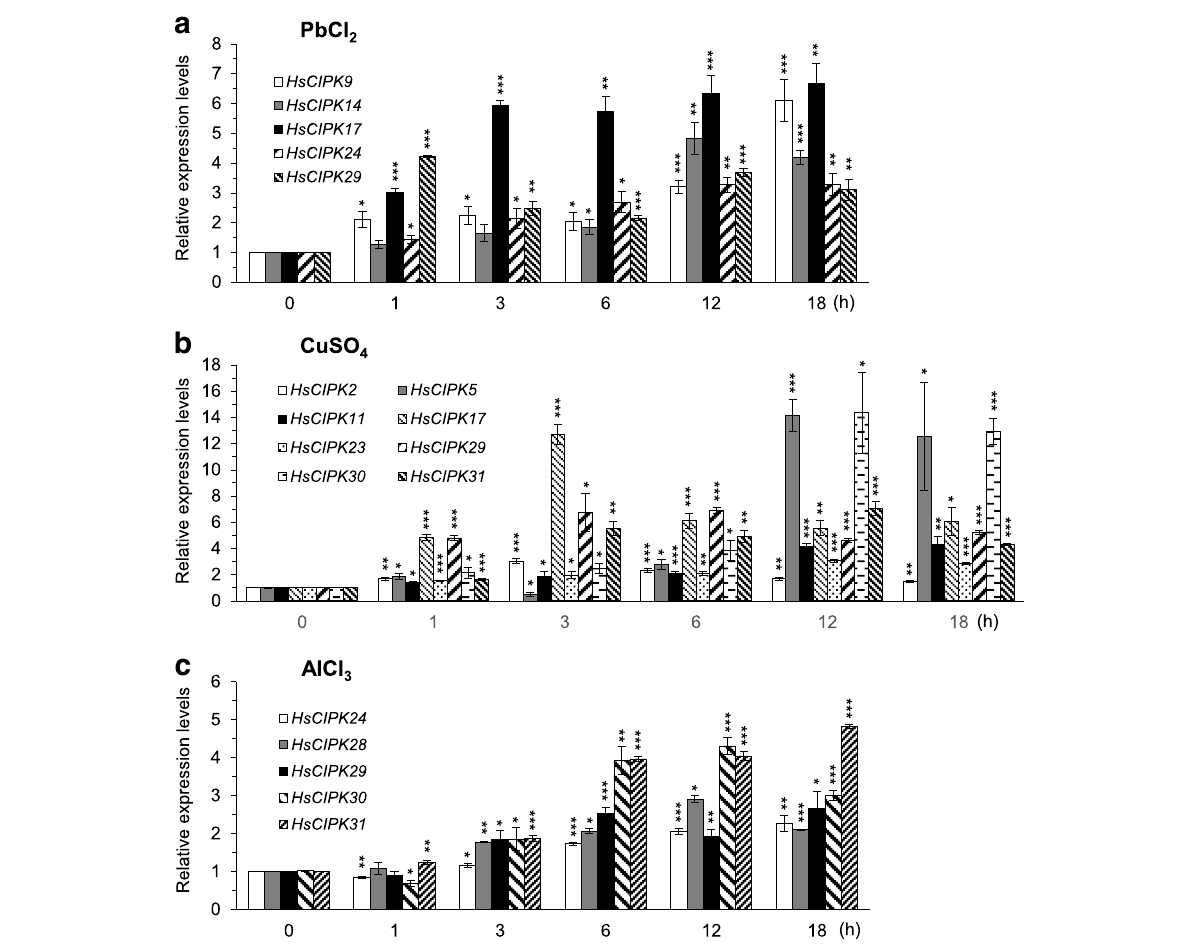
Fig. 3 Pb-, Cu-, and Al-induced expression patterns of HsCIPKs . a-c Relative expression levels of HsCIPKs in four-day-old wild barley seedlings treated for different time lengths (0, 1, 3, 6, 12, and 18 h) with 20 μ M PbCl 2 ( a ), 1 mM CuSO 4 ( b ), and 20 μ M AlCl 3 ( c ), respectively. Values shown are means ± SD. Single, double, and triple asterisks indicate P < 0.01, 0.001, and 0.0001, respectively ( t test; compared to the corresponding 0-time point mock control). The expression level of the 0-time point mock control for each HsCIPK was set as